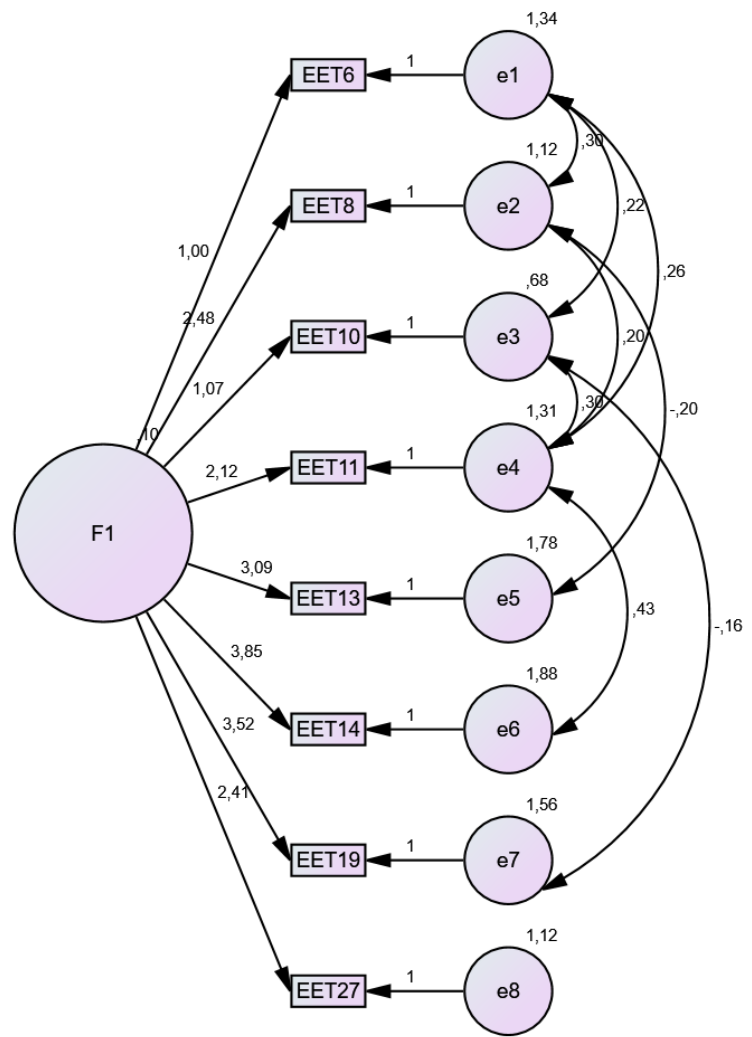
Figure 3. Model 2 for the TWS Short Form